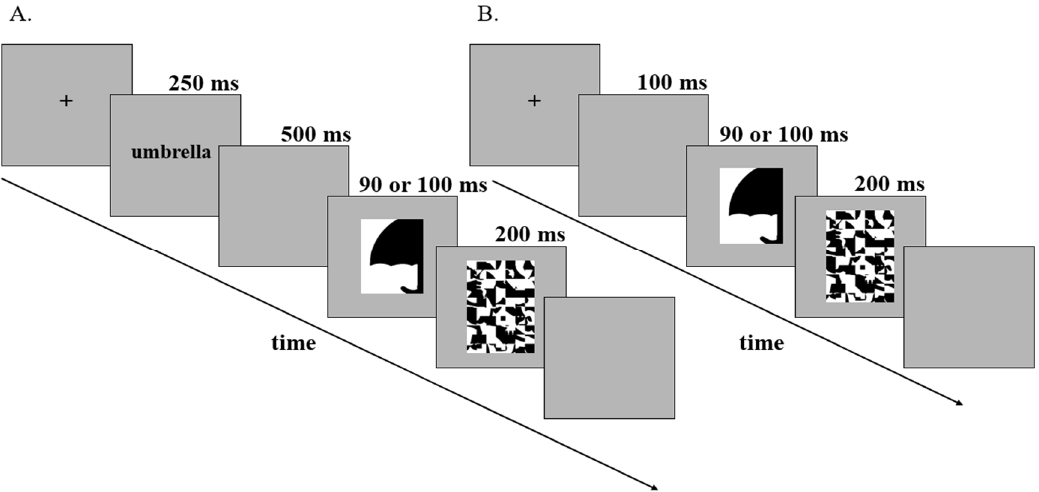
Figure 2. Trial Structures for labels-present and labels-absent experiments. ( A ) Trial structure for labels-present experiments (Studies 1 and 2). Following fixation, a label was displayed for 250 ms. The label was either valid or invalid. Valid labels denoted the object sketched in the displays at a basic level (e.g., “umbrella,” as depicted above); Invalid DSC labels (Study 1) denoted an unrelated object in a different superordinate-level category (e.g., “squirrel”); and Invalid SSC labels (Study 2) denoted an unrelated object in the same superordinate-level category (e.g., “envelope”). After a 500 ms blank screen, the test display was shown for either 90 ms or 100 ms (these durations were tested in separate experiments) and was followed by a 200 ms mask. The test display shown above depicts a portion of an upright umbrella sketched on the right side of the central border in black. During the experiments, the portions of common objects sketched on the critical sides of the borders were shown equally often on the left/right, in black/white, and upright/inverted. Task: Report the side on which they perceive a figure. The last, blank, screen was shown until response or 4 sec (timeout). ( B ) Trial structure for labels-absent experiments (control). Following fixation, a blank screen was displayed for 100 ms. As in labels-present experiments, the test display was shown for either 90 ms or 100 ms (durations tested separately) and was followed by a 200 ms mask. During the experiments, the portions of common objects sketched on the critical sides of the borders were shown equally often on the left/right, in black/white, and upright/inverted. Task: Report the side on which they perceive a figure. The last, blank, screen was shown until response or 3 s (timeout).